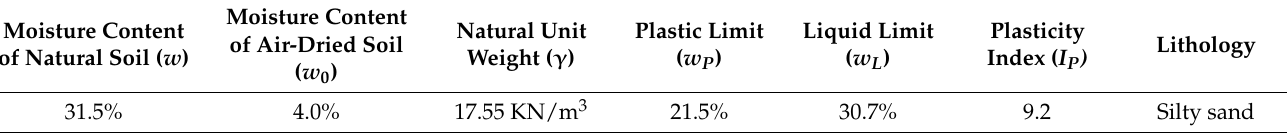
Table 1. Physical parameters of test soil samples.